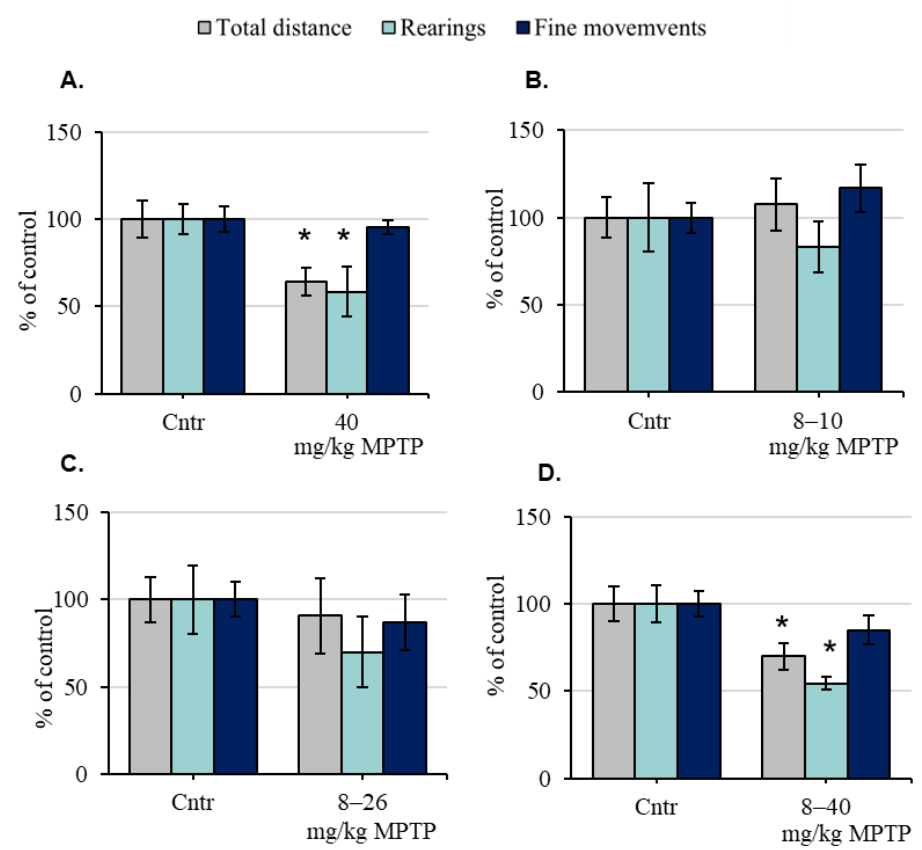
Figure 1. The motor behavior of mice in the open field test, assessed by the total distance, number of rearings, and number of fine movements in % of the control after 24 h: after a single injection of 1-methyl-4-phenyl-1,2,3,6-tetrahydropyridine (MPTP) at a dose of 40 mg/kg ( A ), after successive MPTP injections at doses of 8 and 10 mg/kg ( B ), after successive MPTP injections at doses of 8, 10, 12, 16, 20, and 26 mg/kg ( C ), and after successive MPTP injections at doses of 8, 10, 12, 16, 20, 26, and 40 mg/kg ( D ) (“n” per group = 10–12). * p < 0.05, significant differences compared with the control, taken as 100% (the Student’s t -test). Data are presented as mean ± SEM. Cntr—the control group received 0.9% NaCl.